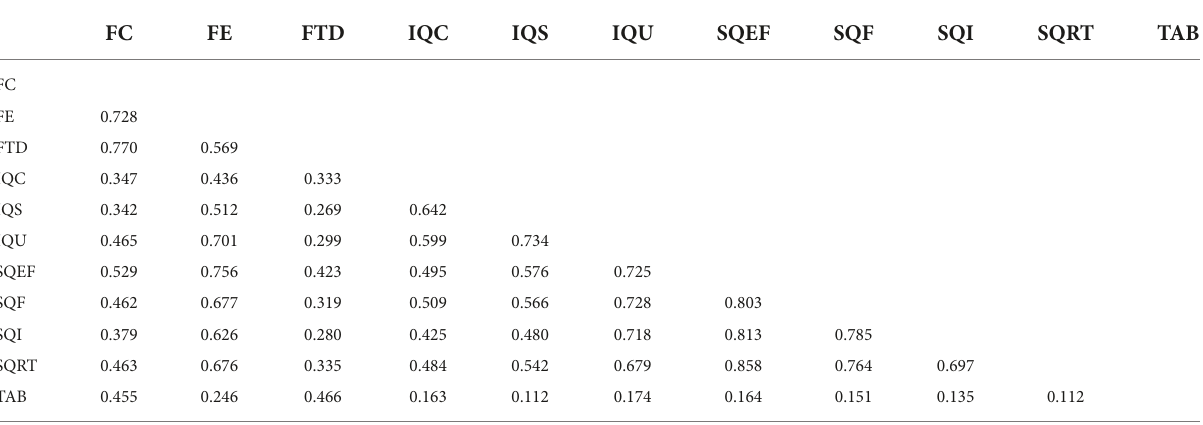
TABLE 4 Discriminant validity: Heterotrait Monotrait (HTMT) criterion.